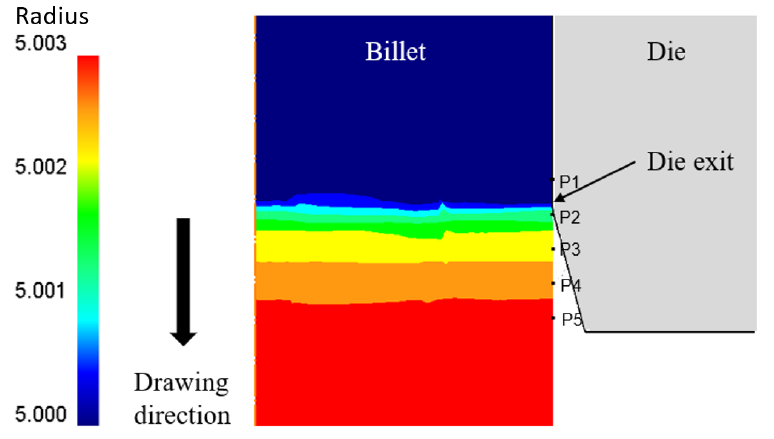
Figure 4. Radius changes of billet near die